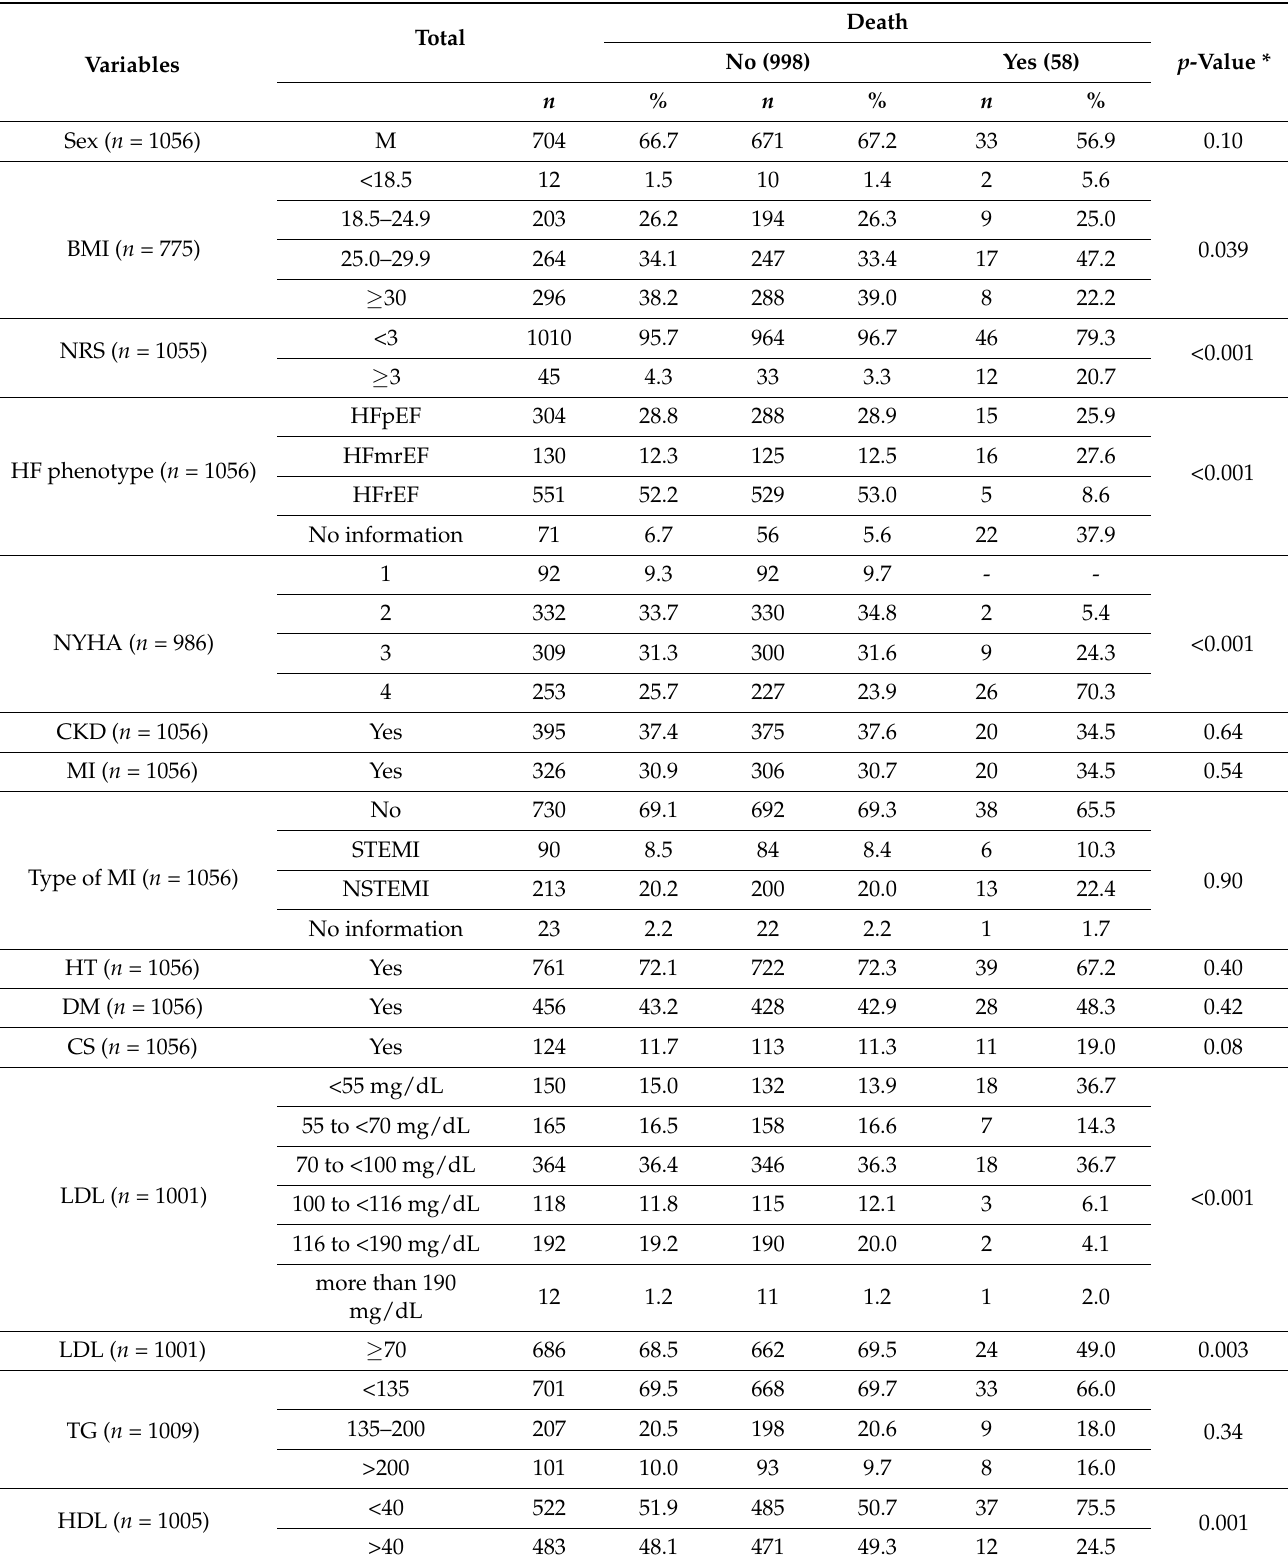
Table 1. Characteristics of the group with a comparison of survivors and